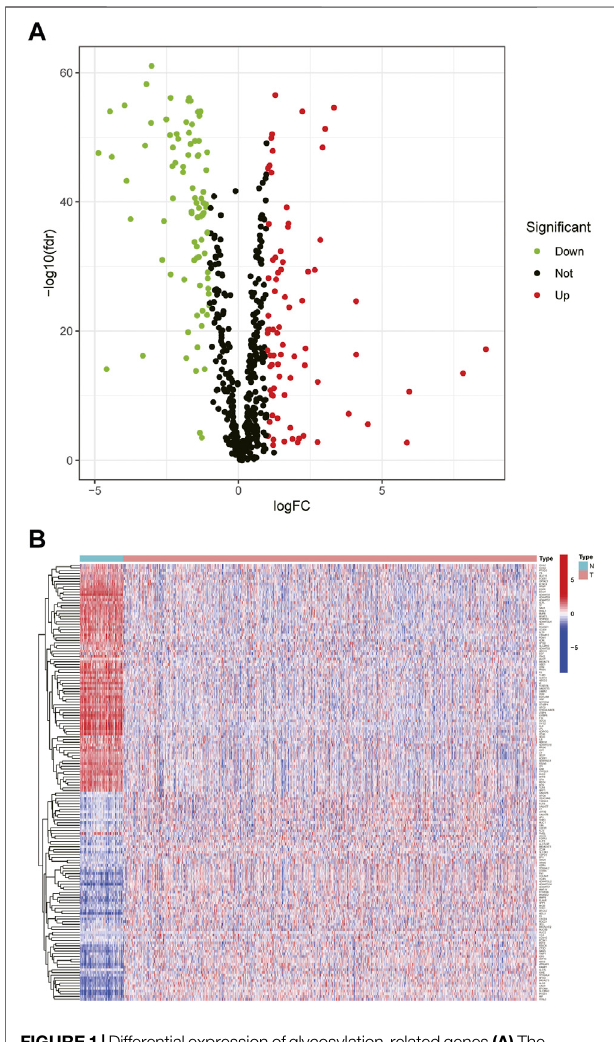
FIGURE1| Differentialexpressionofglycosylation-relatedgenes (A) The volcano plot showed the up-regulated and down-regulated differential genes in breast tumor tissues compared with adjacent tissues (t-test, Adjust. p < 0.05) (B) The heat map showed that 163 differential glycosylation- related genes were expressed in tumor tissues and adjacent tissues.